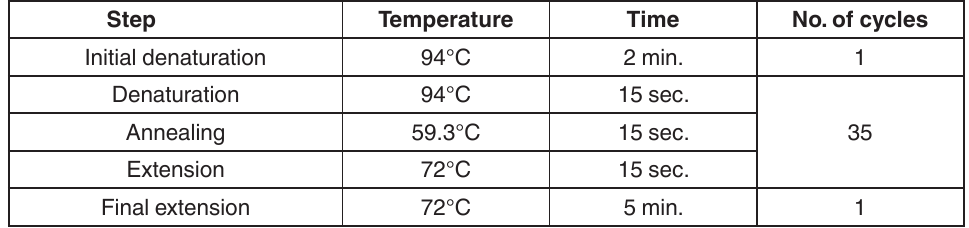
table 1. PCR conditions for amplification of 16S rRNA gene specific to genus